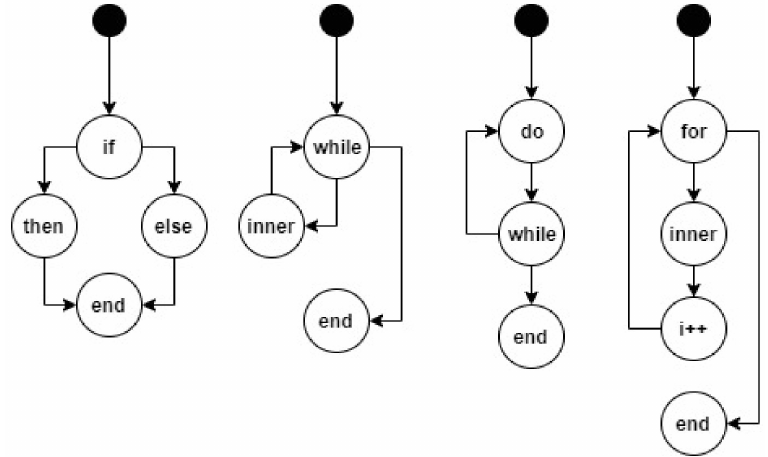
Figure 1. Flowchart. From left to right: if-then-else and do-while